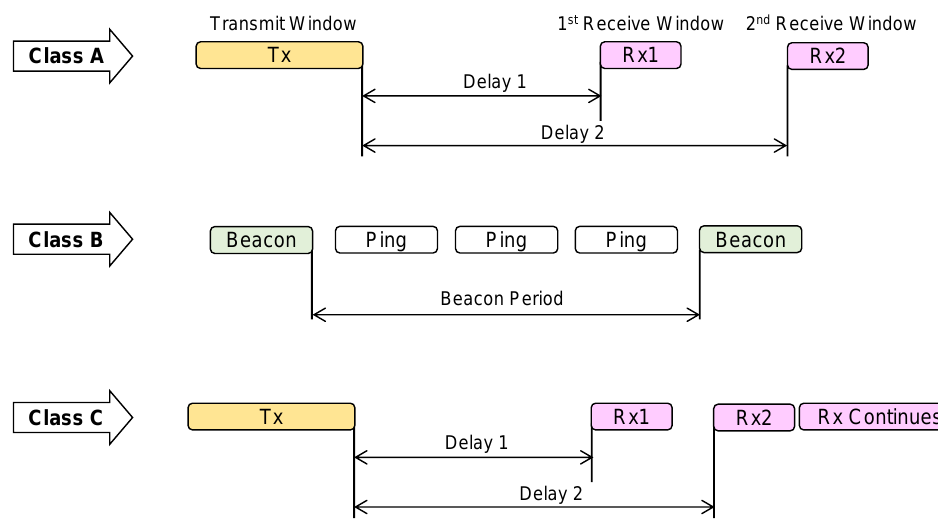
Figure 16. Tx/Rx windows for Class A, Class B, and Class C devices. Table 11. Key works developed using LoRa technology.